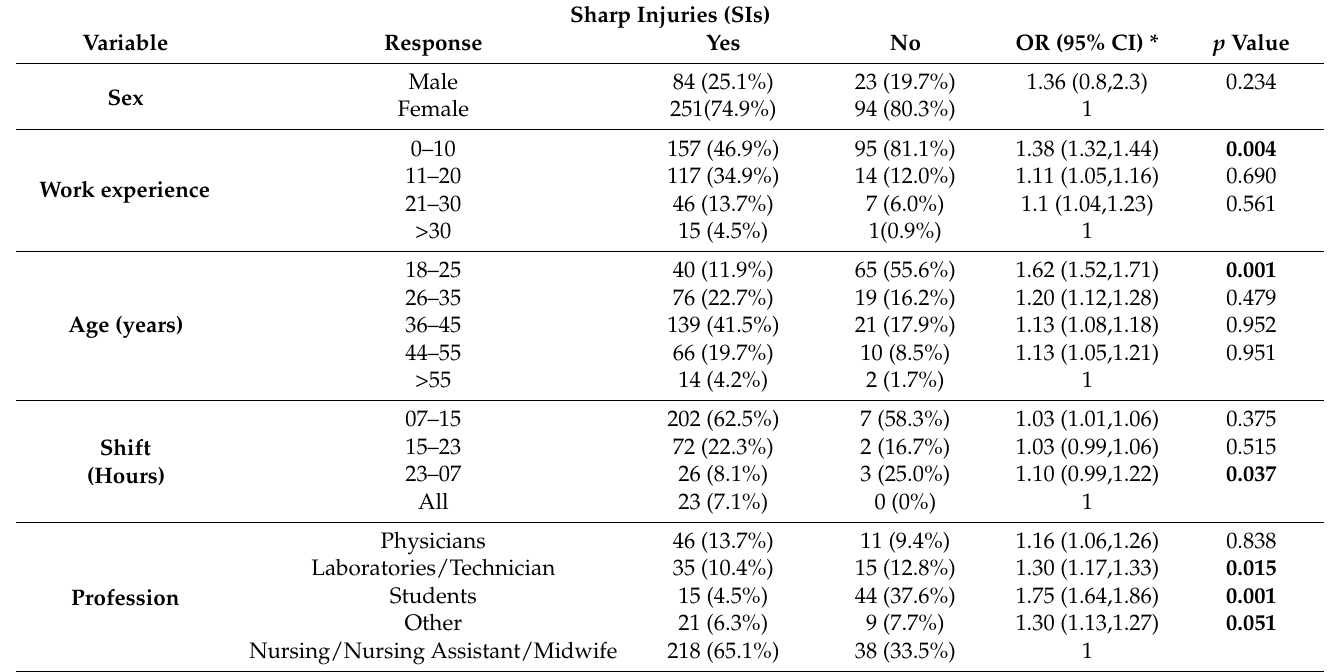
Table 4. Bivariate and multivariate logistic regression analysis of factors associated with